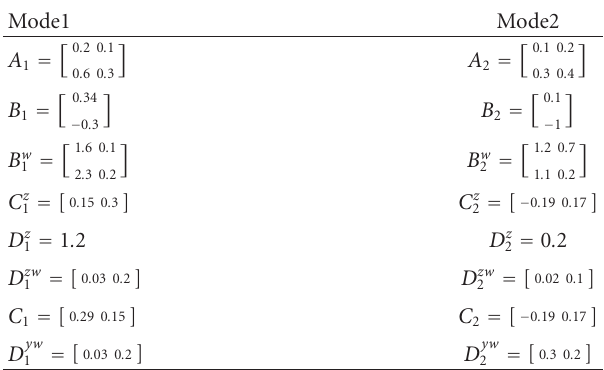
Table 2: Numerical example.